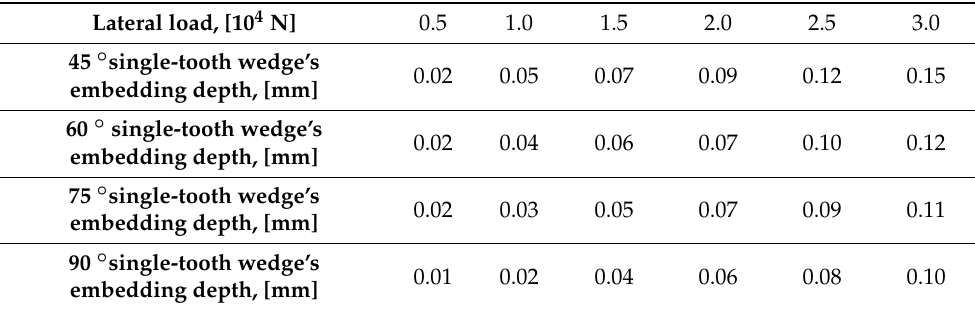
Table 2. The relationship between the embedding depth and loading force of single tooth wedges with different tooth angles.